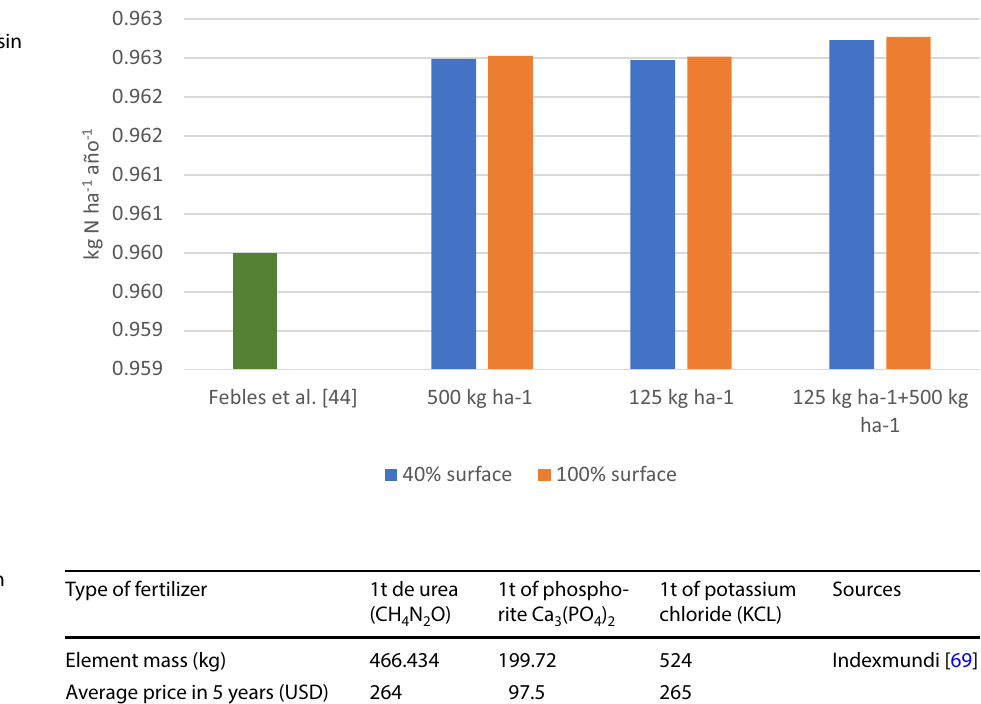
Table 3 Value of fertilizers on the international market